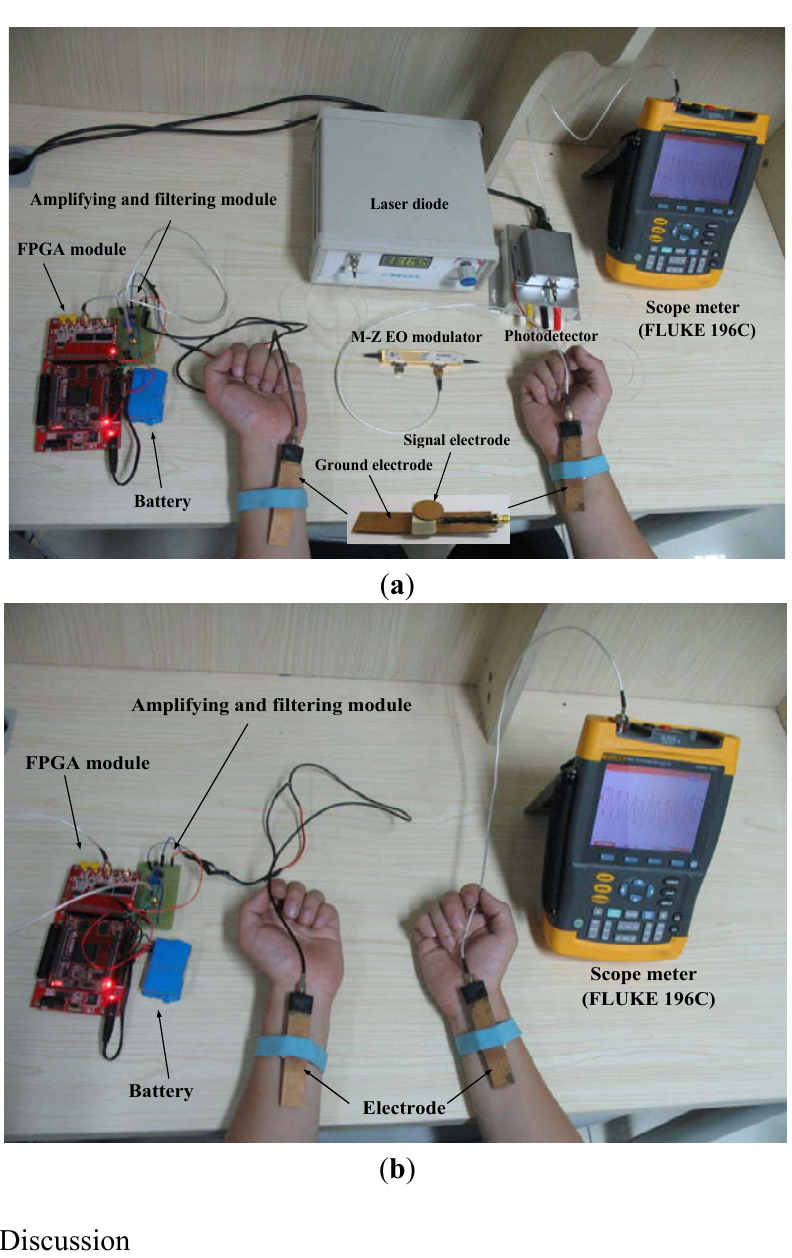
Figure 5. Experiment device with respect to the frequency response of signal transmission system based on human body, in which ( a ) is the experiment device based on Mach-Zehnder EO sensor, and ( b ) is the experiment device based on electronic